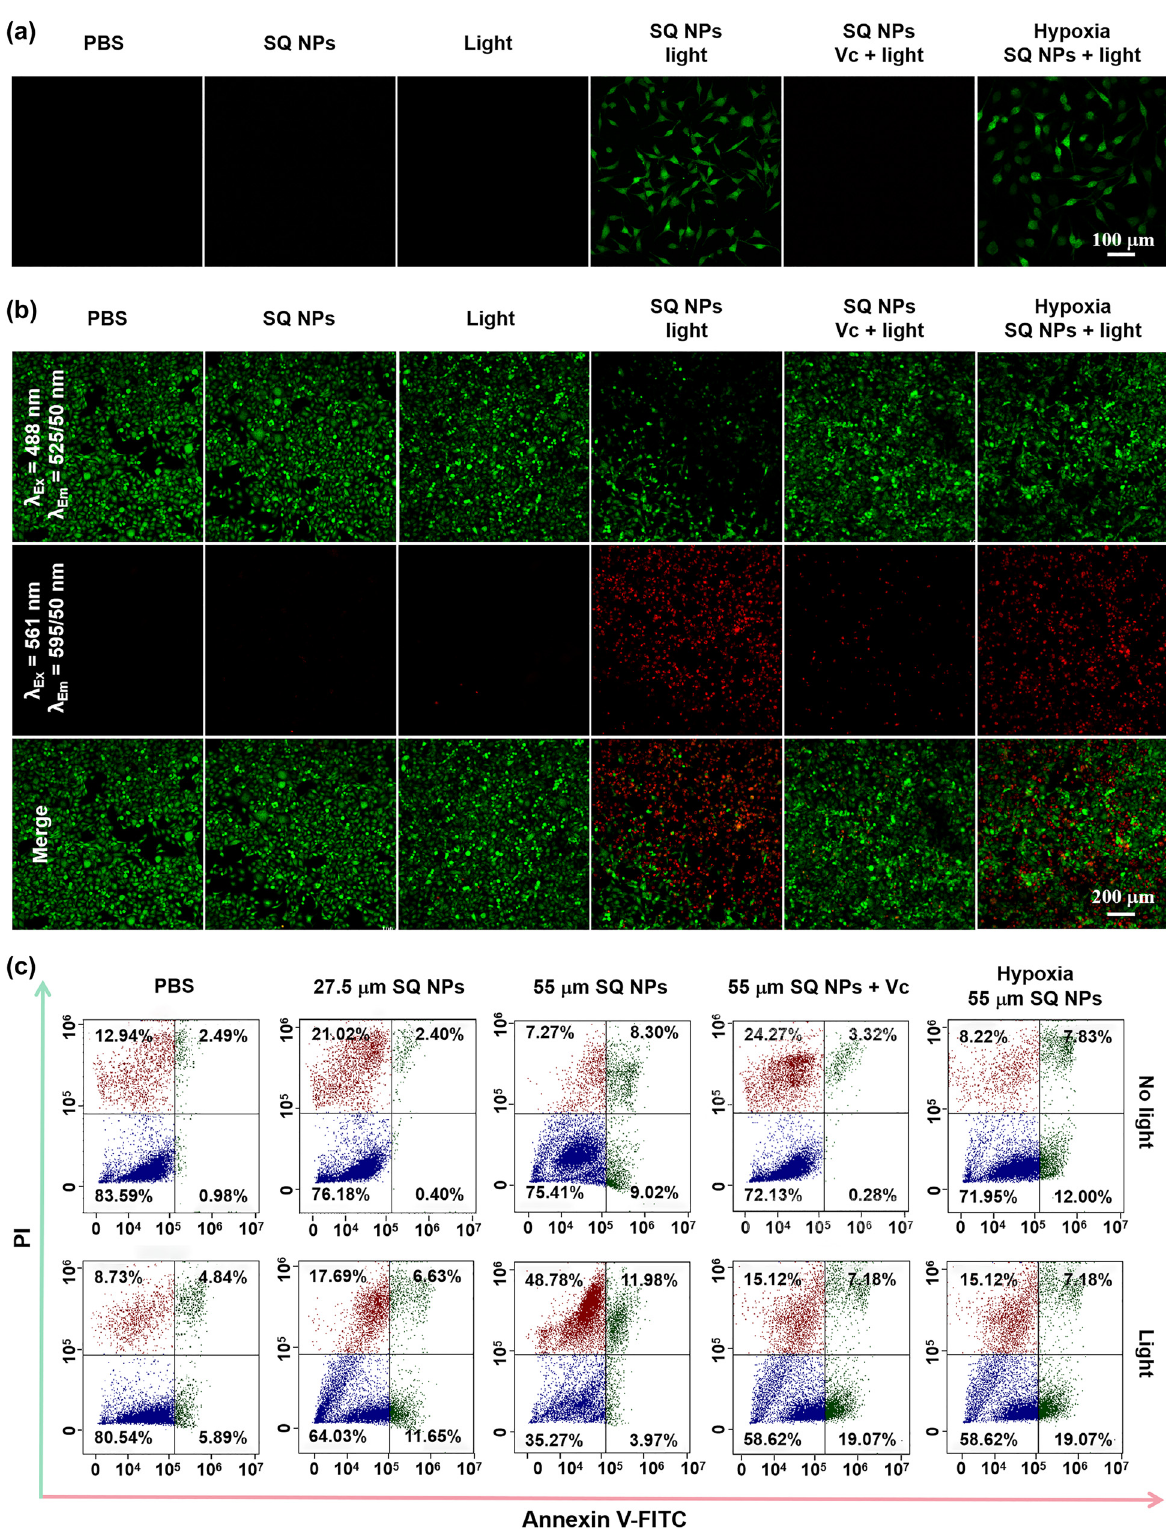
Figure 3: ROS production and PDT capacity of SQ NPs in vitro samples. (a) ROS production capacity of SQ NPs in SH-SY5Y cells treated with (I) PBS, (II) SQ NPs, (III) light, (IV) SQ NPs + light, (V) SQ NPs + Vc + light and (VI) hypoxia SQ NPs + light. (b) PDT capacity of SQ NPs on SH-SY5Y with treatments: (I) PBS, (II) SQ NPs, (III) light, (IV) SQ NPs + light, (V) SQ NPs + Vc + light and (VI) hypoxia SQ NPs + light. (c) Apoptosis analysis of SH-SY5Y cells with various treatments. (Green channel: 500–550 nm, excited at 488 nm; red channel: 570–620 nm, excited at 561